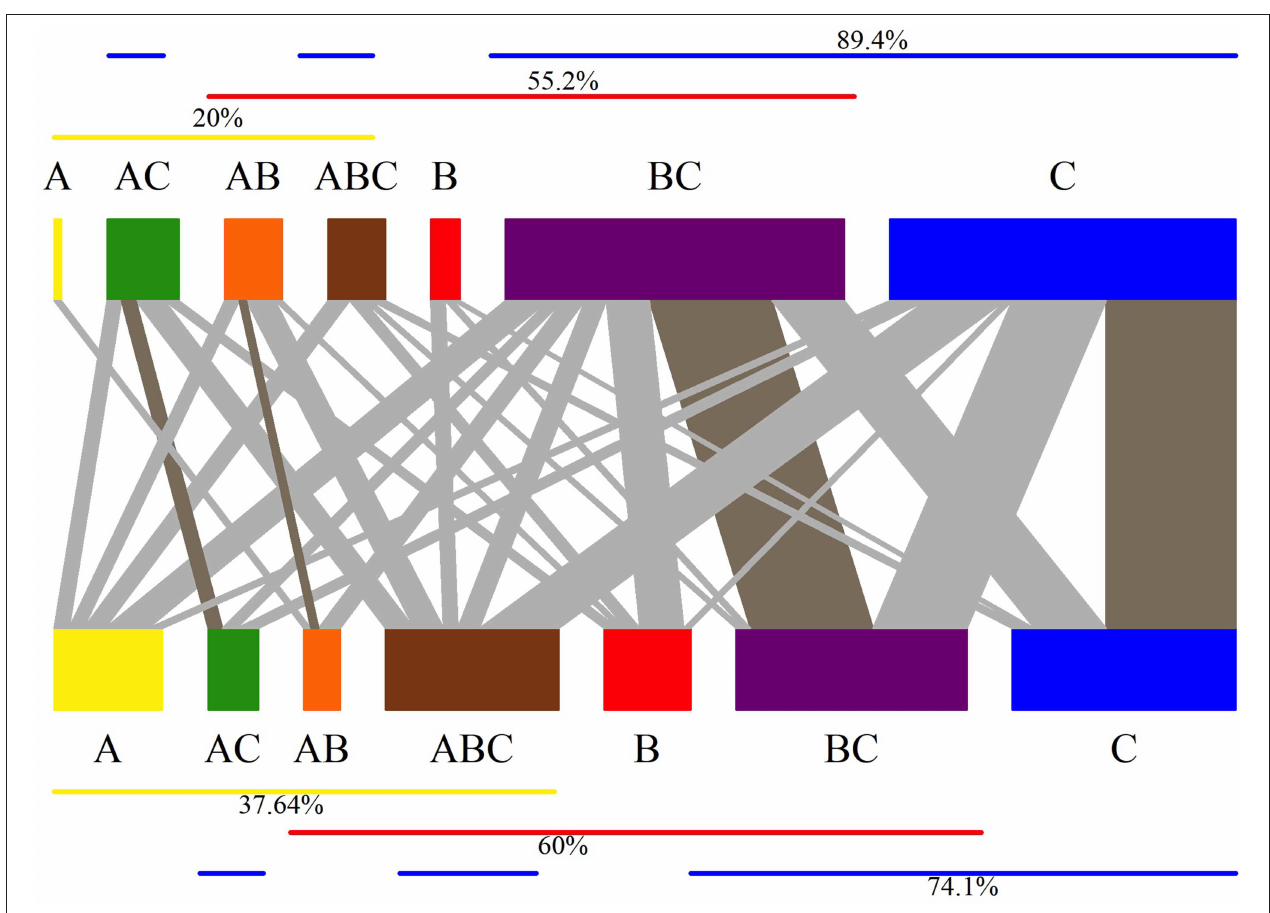
FIGURE 5 | Proportion of connections within and between categories. Darker lines correspond to unique connections or those linking components from the same category.